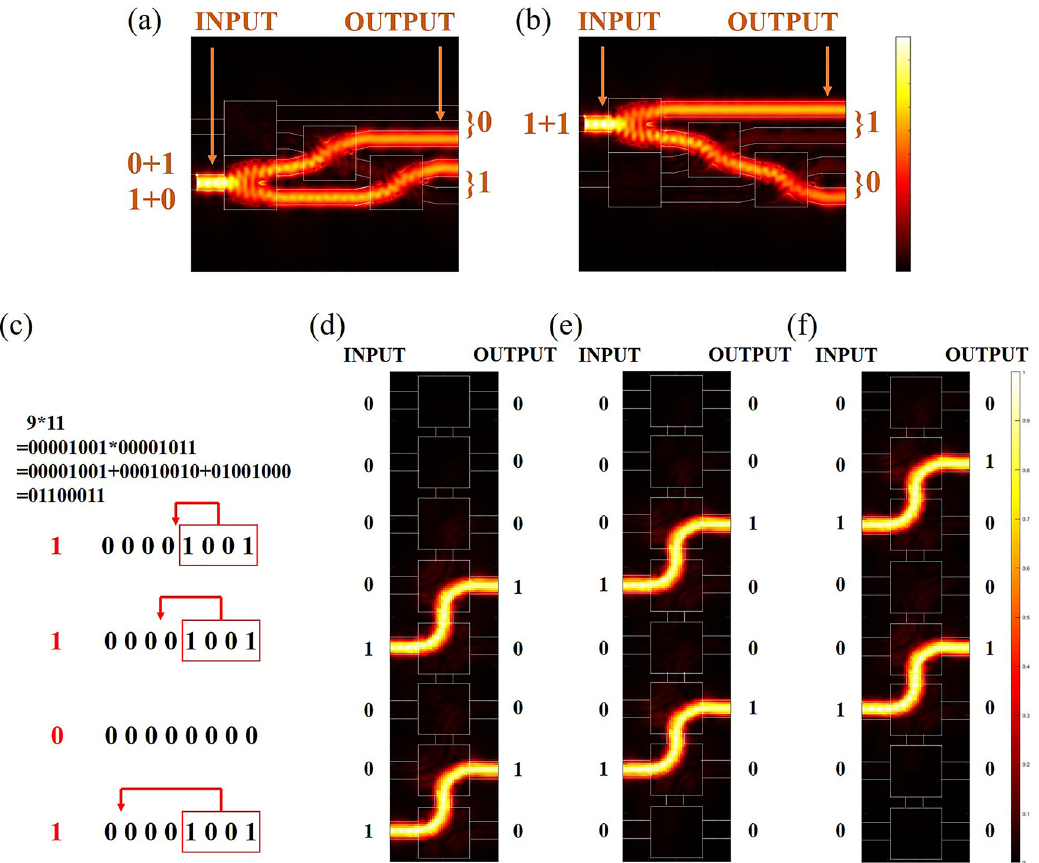
Figure 5: Simulation results of all-optical calculation part. (a)The “ 0 + 1 ” or “ 1 + 0 ” inputstatesofnormalizedintensitydistributioninthe x – y planefromtheoreticalcalculation.(b)The “ 1 + 1 ” inputstate of normalized intensity distribution in the x – y plane from theoretical calculation. (c) The basic working principle of the all-optical binary shifter. (d) The “ 00001001 ” states of normalized intensity distribution in the x – y plane from theoretical calculation, the output result is “ 00010010 ” . (e) The “ 00010010 ” states of normalized intensity distribution in the x – y plane from theoretical calculation, the output result is “ 00100100 ” . (f) The “ 00100100 ” states of normalized intensity distribution in the x – y plane from theoretical calculation, the output result is “ 01001000 ”